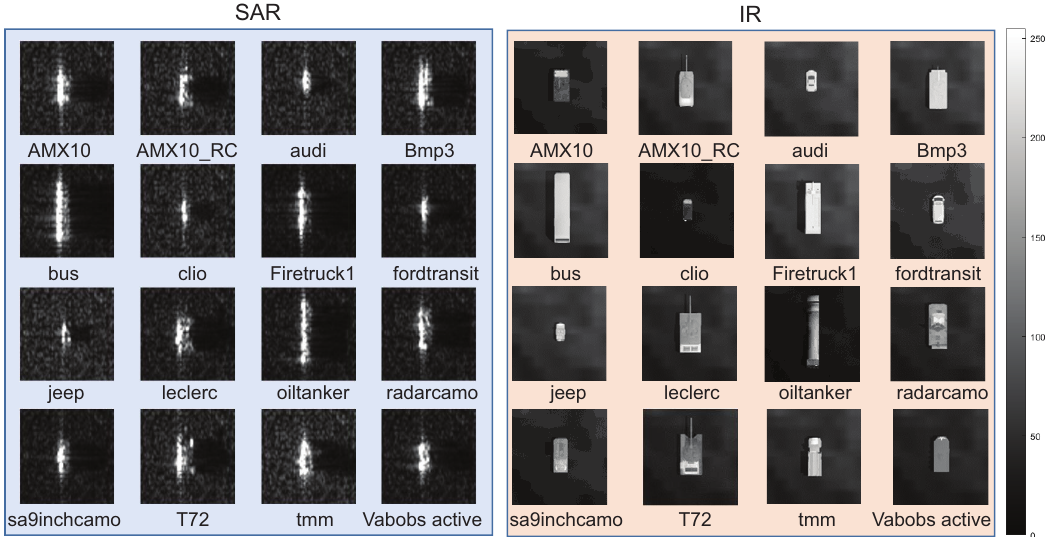
Figure 5. Examples of SAR and IR target generation using